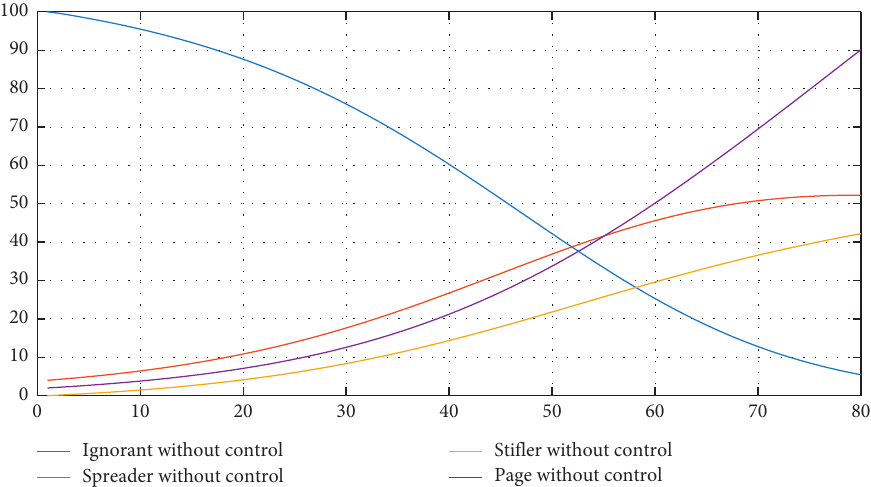
Figure 2: Dynamics without control